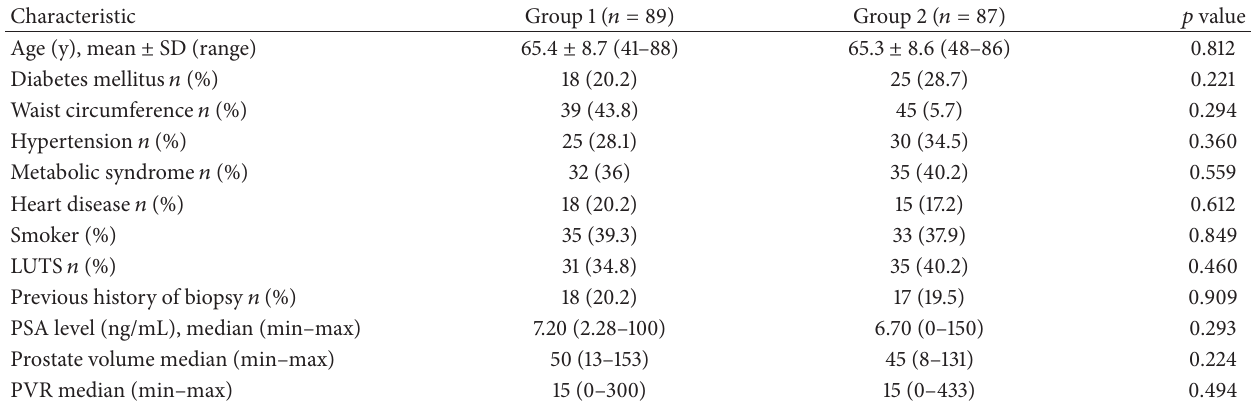
Table 1: Characteristics of patients in the groups.